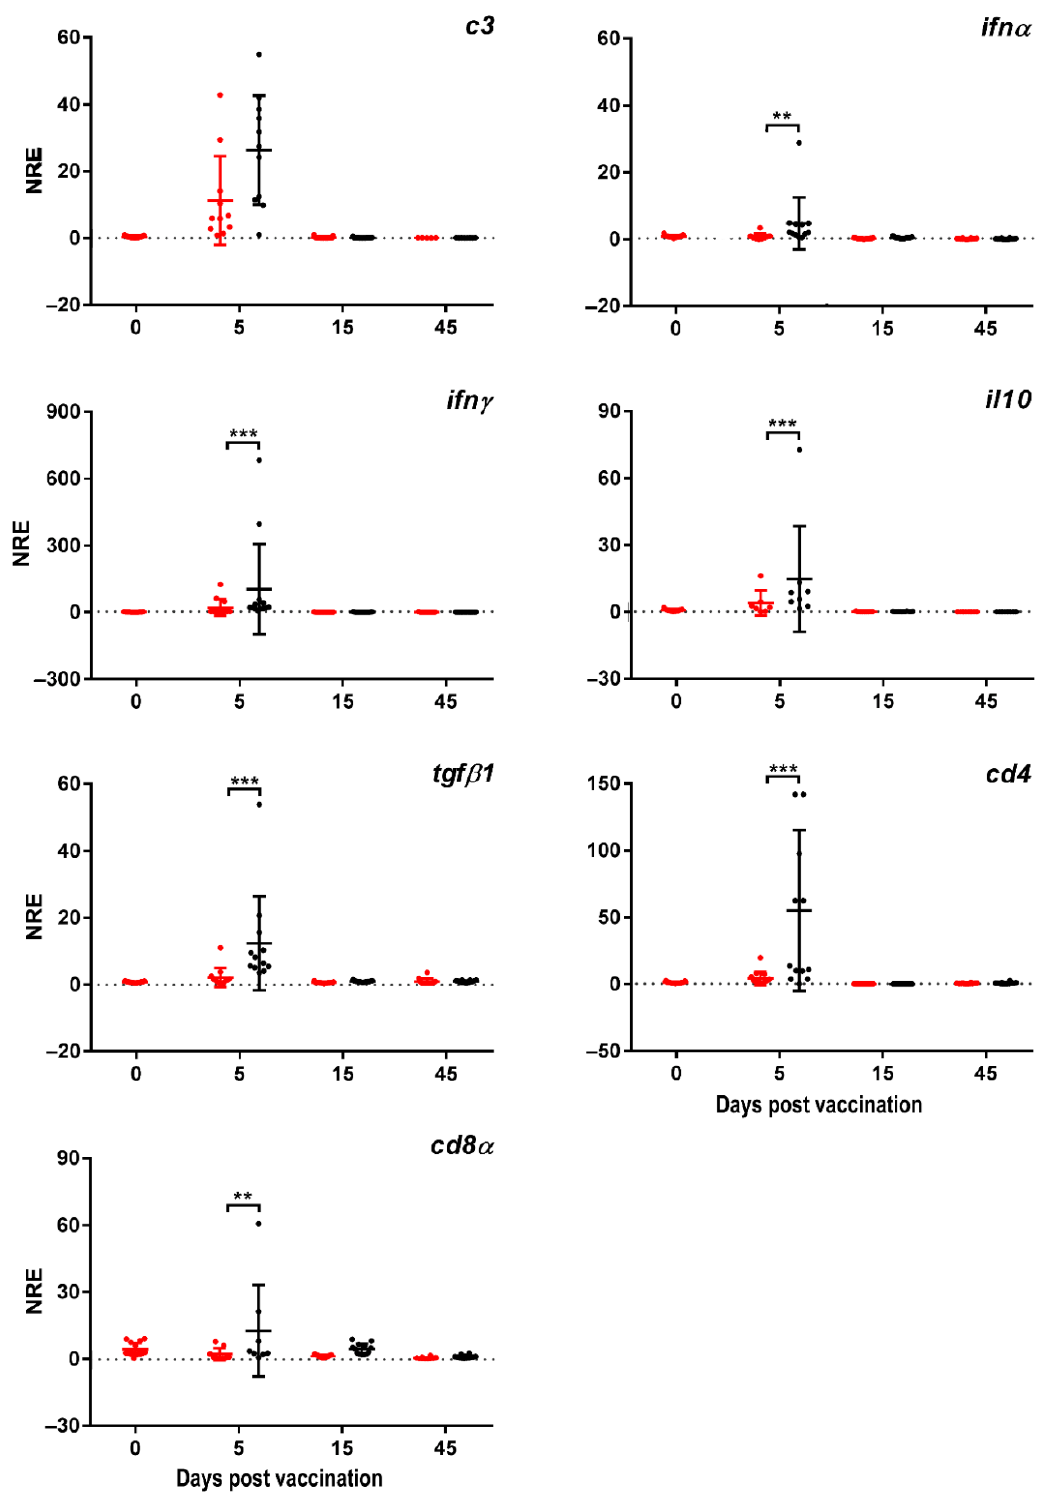
Figure 1. Normalized relative expression (NRE) of immune-related genes for vaccinated (black dots) and non-vaccinated Atlantic salmon ( Salmo salar ) head kidney. Fish reared under productive conditions were intraperitoneally vaccinated with ALPHA JECT LiVac ® SRS and sampled from both vaccinated and non-vaccinated fish at zero, 5-, 15-, and 45-days post-vaccination (dpv) ( n = 15 fish per treatment and sampling time-point). Two-way ANOVA test and post-hoc Sidak’s multiple comparisons test was conducted ( α = 0.05) to find differences in each time between control and vaccinated groups. Statistical differences were indicated when p value ≤ 0.05. Gene expression results are expressed as the mean ±SD. **, *** p < 0.05. ** p -value < 0.01, *** p -value <